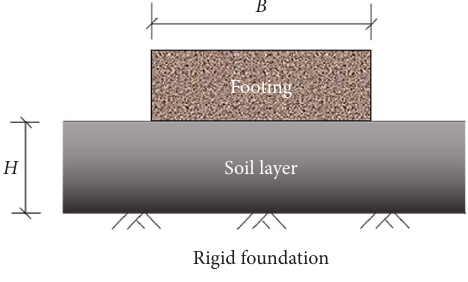
Figure 6: The problem